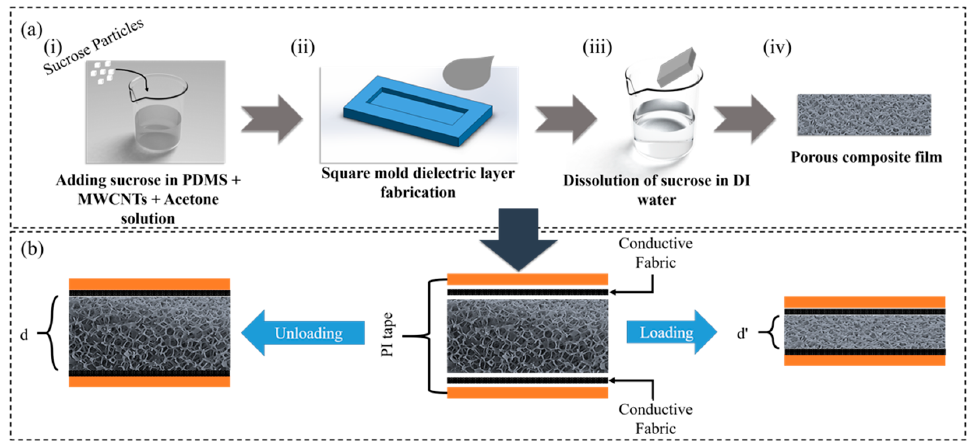
Figure 1. ( a ) Schematic illustration of the fabrication process of porous dielectric layer. ( b ) Pressure-sensing mechanism of the CPS with porous dielectric layer.